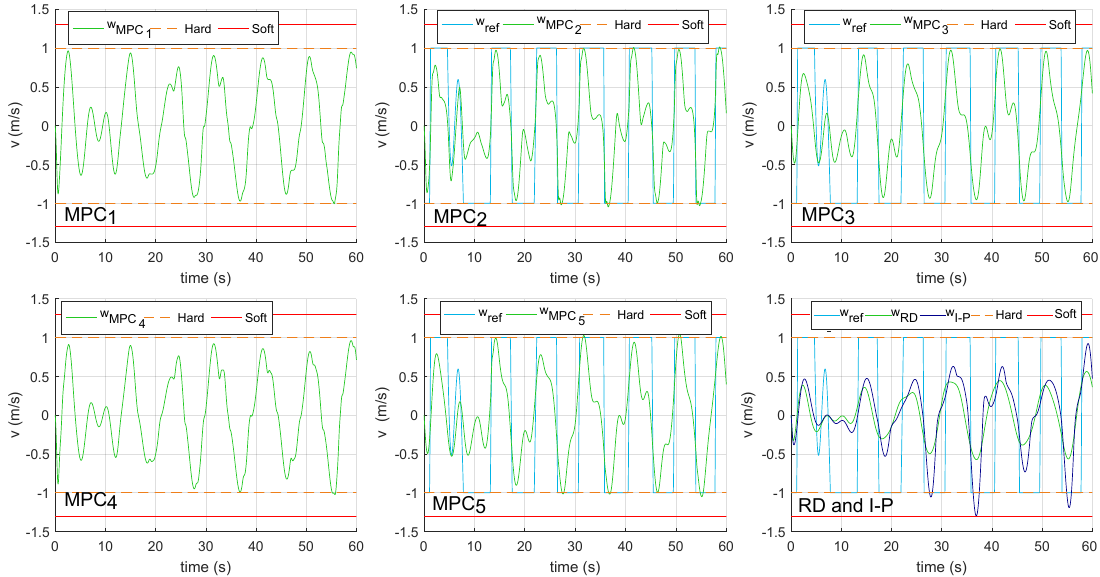
Figure 7. Simulation of the oscillation speeds obtained in the WEC system when applying the seven controllers to the mathematical model